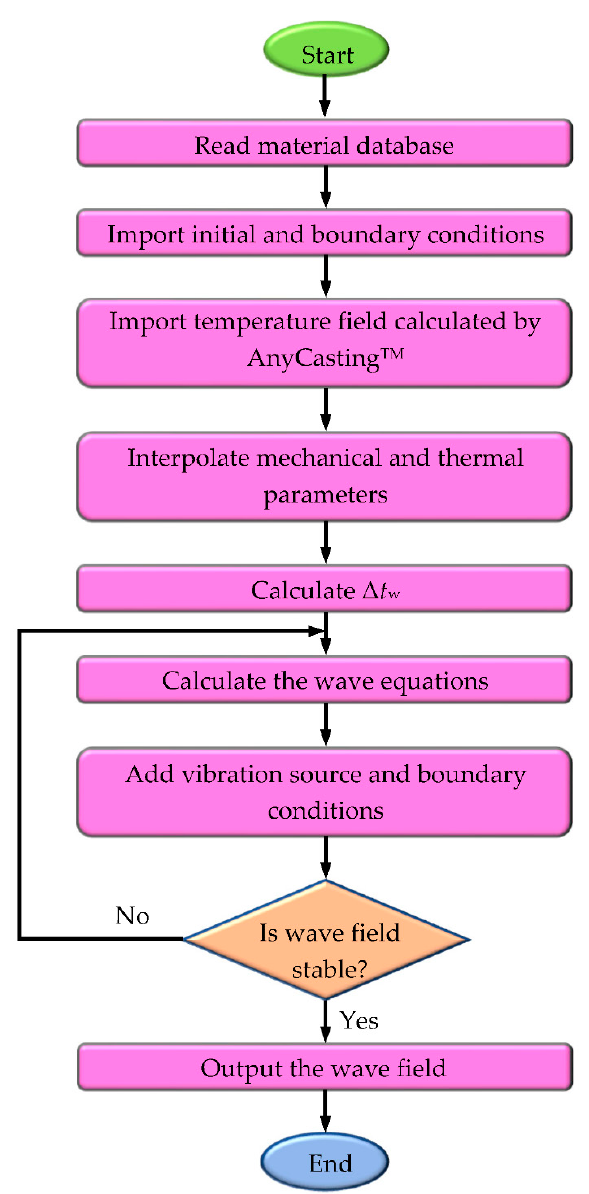
Figure 3. Procedures of coupling calculation of the temperature field and wave field.